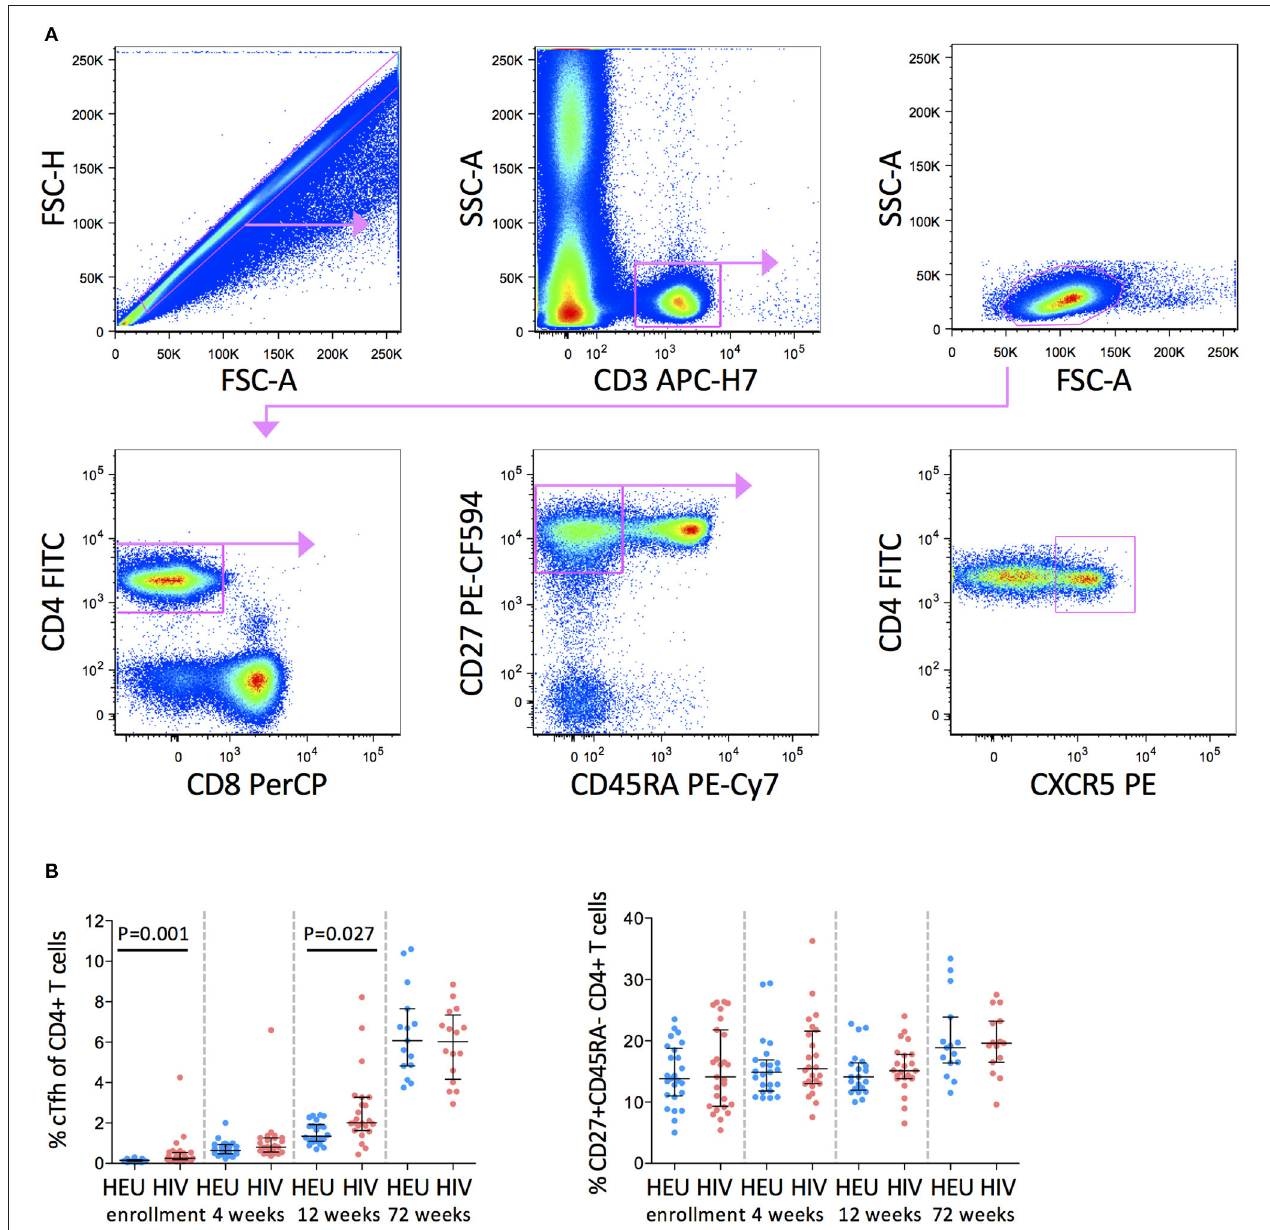
FIGURE 1 | cTfh cells are increased in HIV-1-infected infants in early life. (A) Pseudocolor plots showing representative gating of cTfh cells. Singlets are identified using FSC-H against FSC-A followed by gating on CD3 + T cells. CD3 + T cells are further gated on low SSC-A vs low FSC-A. Subsequently, CD27 + CD45RA- memory T cells are gated from CD4 + T cells and cTfh cells are identified by CXCR5 expression. (B) Frequencies of cTfh cells (left) and CD27 + CD45RA- CD4 + T cells (right) in HEU and HIV-1-infected infants at enrollment, 4, 12, and 72 weeks. Each symbol represents an infant. Horizontal lines and error bars represent the median, 25 and 75th percentiles. The significant P -values are